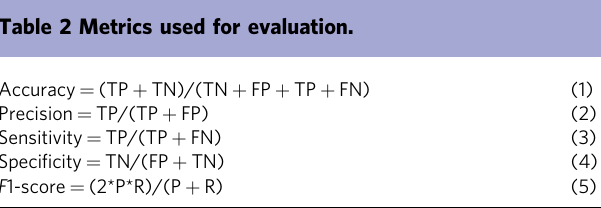
Fig. 5, distributions of internal assessment percentage of the students concerning results are shown as seen two types of pf uncertainty are studied and illustrated.